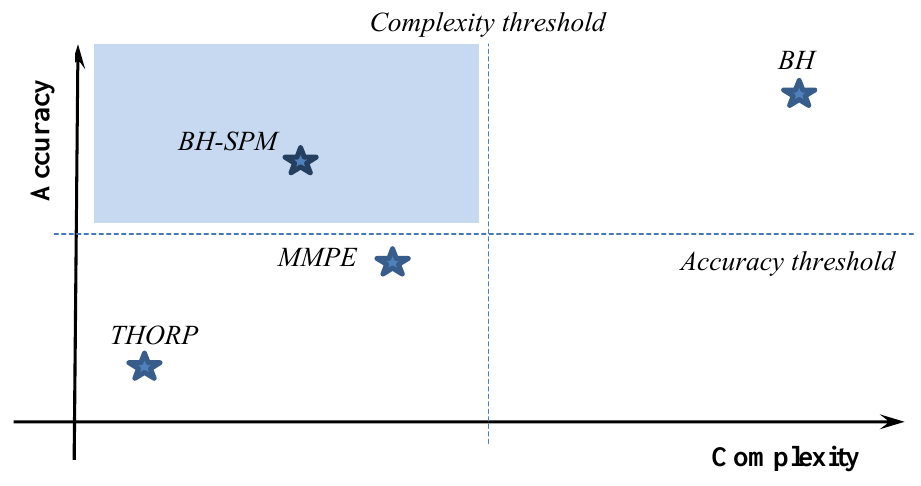
Figure 2. Tradeoff between model propagation accuracy and computational